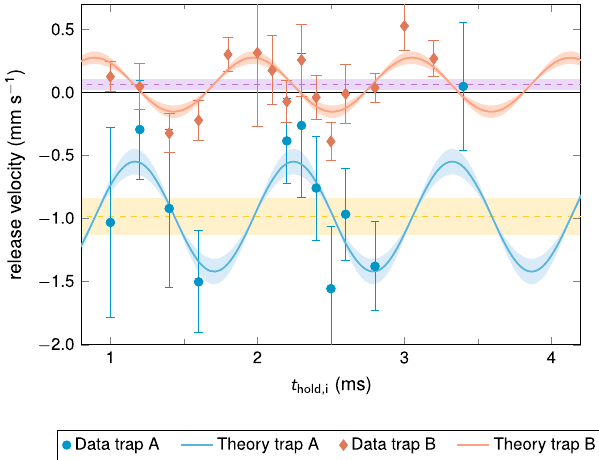
Fig. 3 | Tunable and robust trap release of a BEC. Release velocity of a trans- portedBECasa functionofthe initialholdtime t hold,i forthe twotransport ramps A (blue) and B (red) described in the caption of Fig. 2. Both transports allow for tunable release velocities between − 1.5mms − 1 and +0.5mms − 1 with a minimal uncertainty of 0.117mms − 1 for t hold,i =2.8ms (trap B) representing experimental noise. The release velocities are subject to a trap-dependent systematic shift (yellow and purple dashed lines) given by Δ v A = − 0.98±0.15mms − 1 and − 1 caused by the fi nite switch-off time of the trap. The Δ v B =+0.062±0.045mms data (blue circles and red diamonds) is consistent with an ab-initio theoretical model (blue and red lines) based on a chip simulation and mean- fi eld BEC dynamics(seeMethods).Theerrorbarsandshadedareasshowthe1 σ -con fi dence bounds of the fi ts and the model,